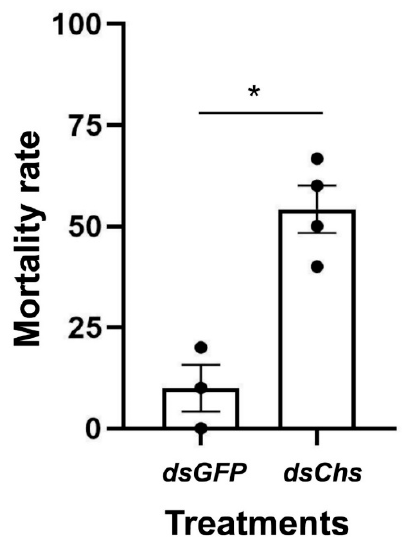
Figure 3. Relative expression levels of CHS2 under immersion treatments with different concentra- tions of dsRNA. The data are denoted as the mean ± the SE. One-way analysis of variance (ANOVA) was used to analyze the relative expression levels of CHS2 under different treatments. Different lowercase letters indicate significant differences among different temperature treatments. Tukey’s multiple range test was used for pairwise comparison for mean separation ( p < 0.05).